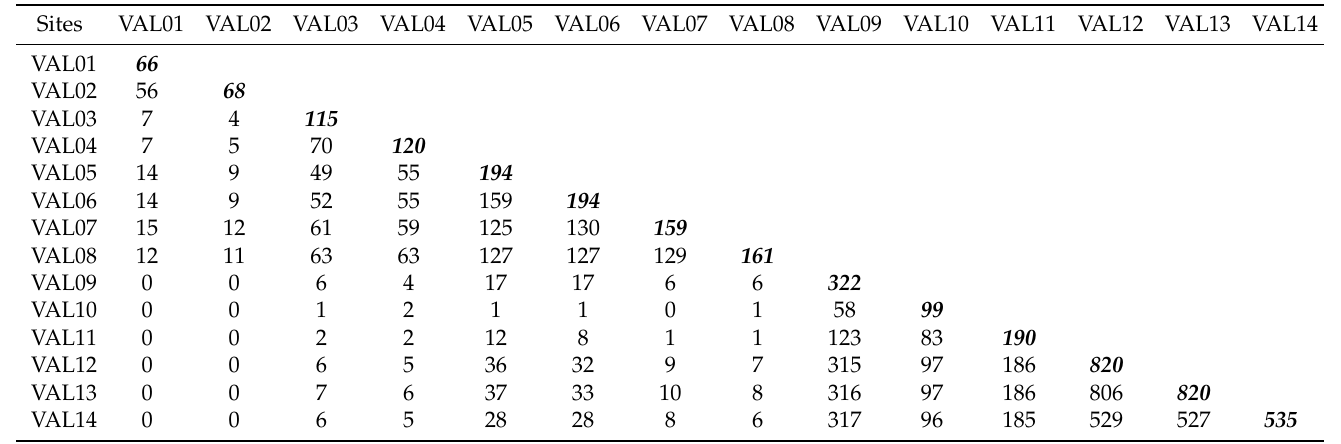
Table A2. Total number of clones tested within sites in the Valdivia zone. On the diagonal is the total number of clones within each site, and on the off-diagonals is the number of common clones tested in pairs of